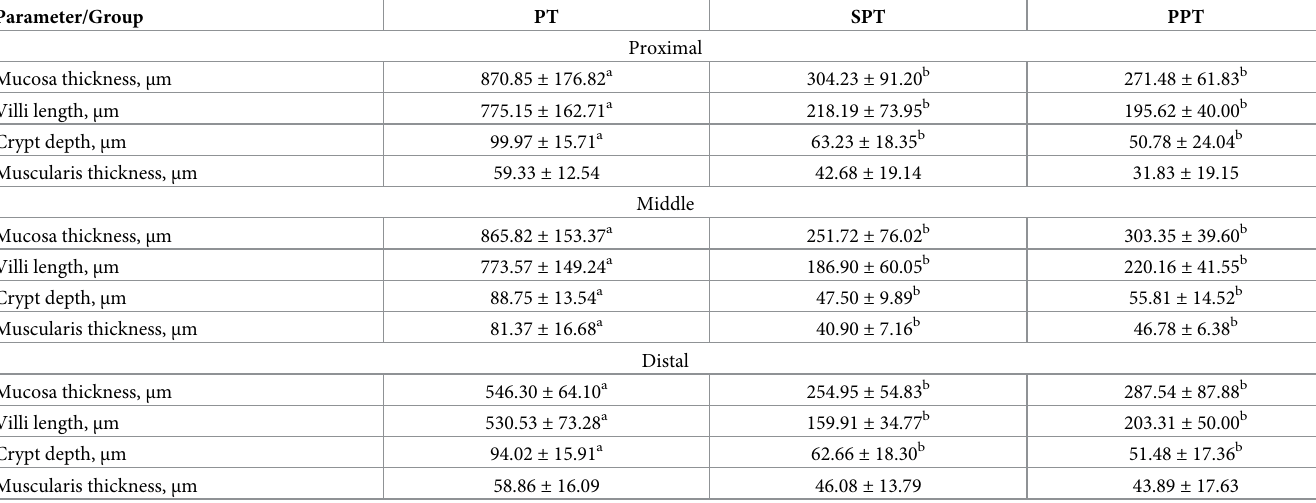
Preterm piglets without treatment—PT, preterm piglets fed infant formula—SPT, and preterm piglets fed pre-hydrolyzed infant formula—PPT. Values are given as Mean ± SD. Data was assessed using an ANOVA, followed by a Tukey post hoc test. a,b,c Values within a row with different superscript letters differ significantly at p < 0.05.